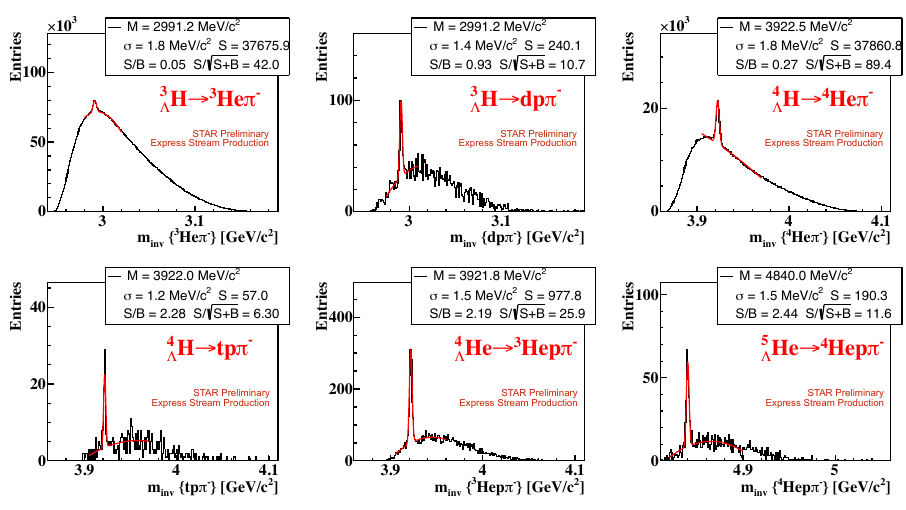
Figure 3. Standard and express reconstruction of hypernuclei using 2018, 2019, 2020, and 2021 data collected at di ff erent energies in the collider and fixed-target modes. The signal of 5 Λ He is visible with a significance of 11.6 σ .